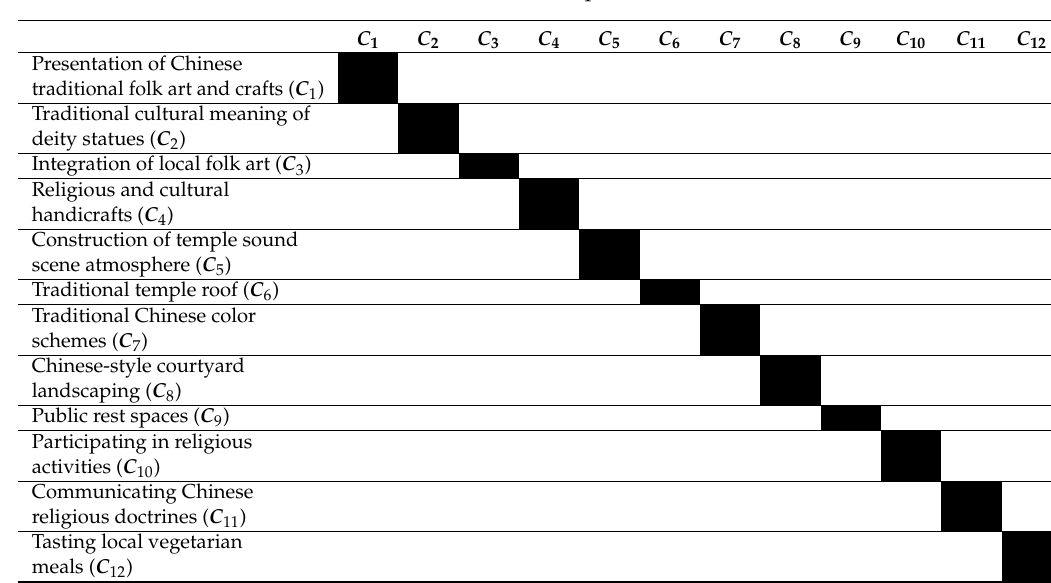
Table A2. DEMATEL